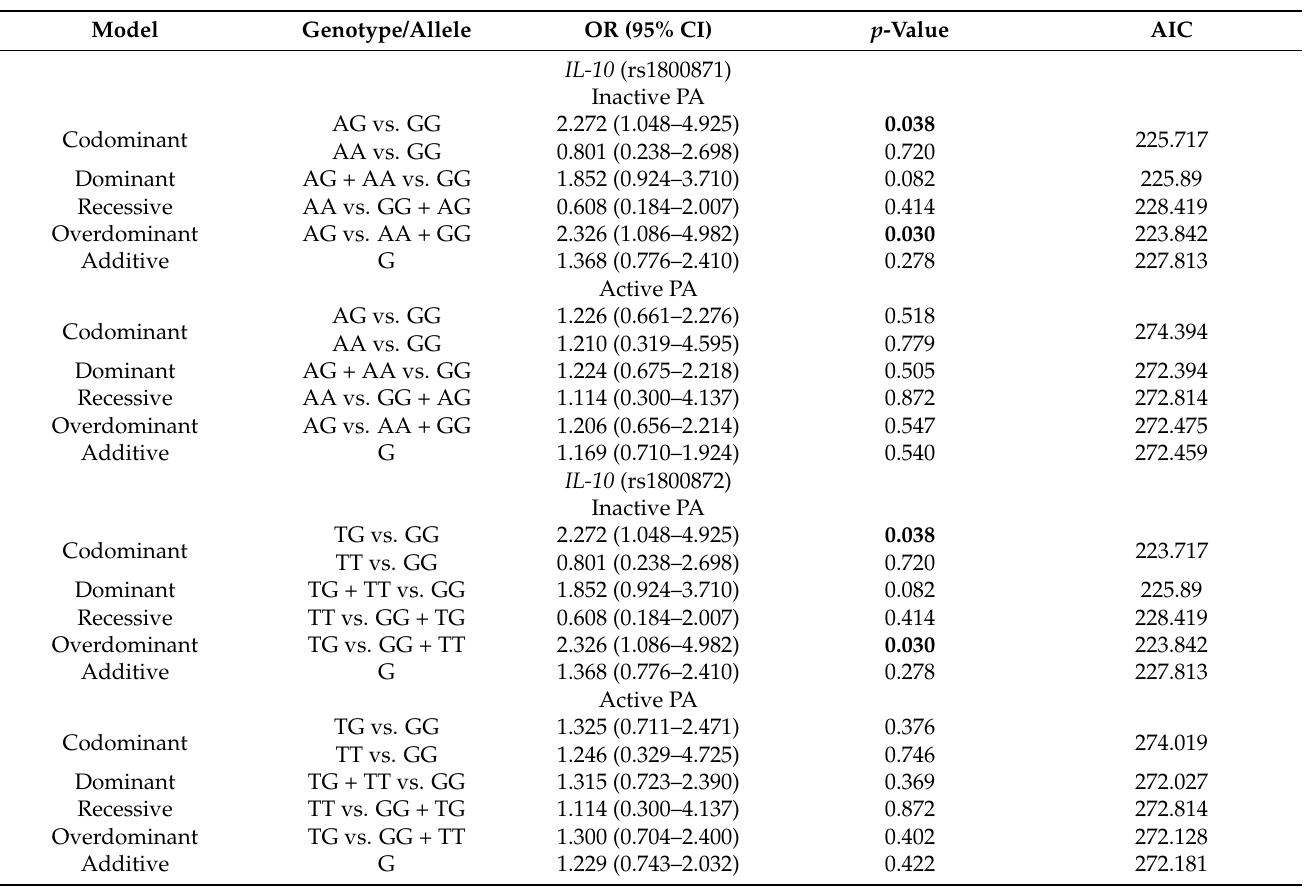
Table 3. Binary logistic regression analysis of IL-10 rs1800871, rs1800872, and rs1800896 in the PA and control groups by PA